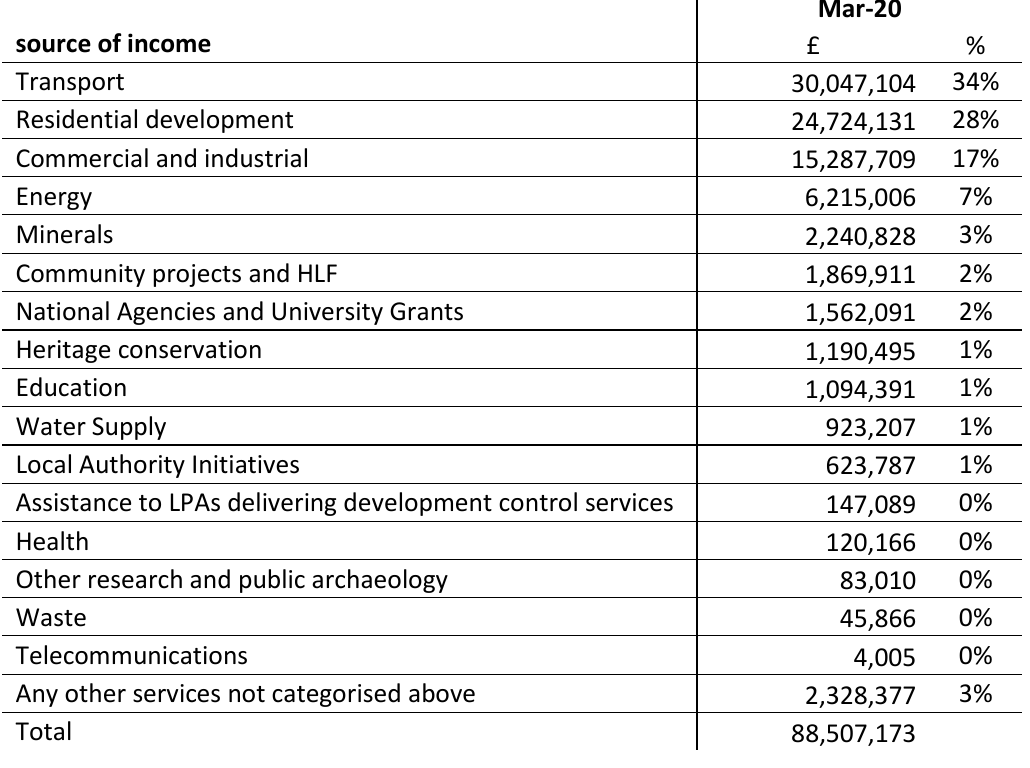
Table 15: Sources of income by sector 2019-20.